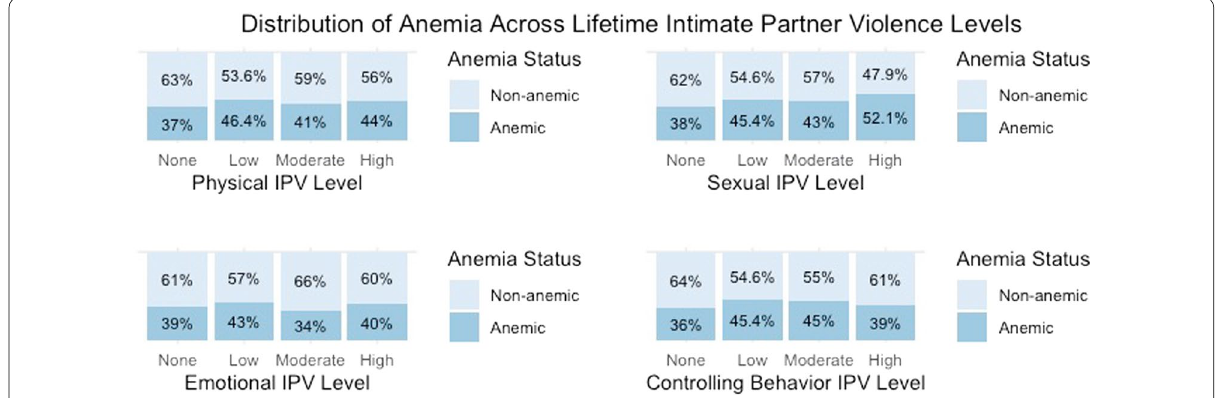
Fig. 4 Distribution of anemic status across lifetime IPV intensity